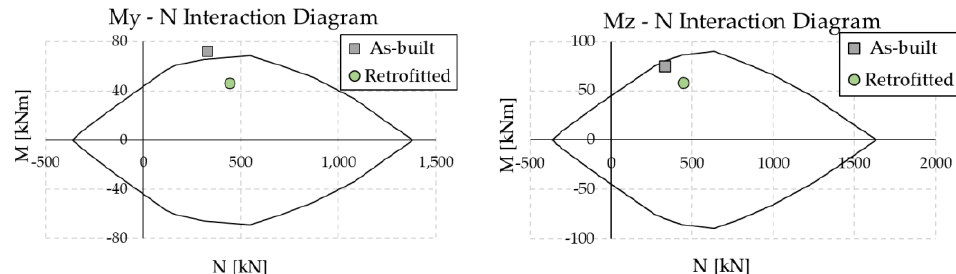
Figure 20. Check of column C11 (Figure 12a) at the ground floor of the RC structure in the M – N interaction diagram.